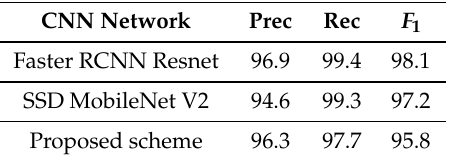
Table 5. Performance of different models for litter